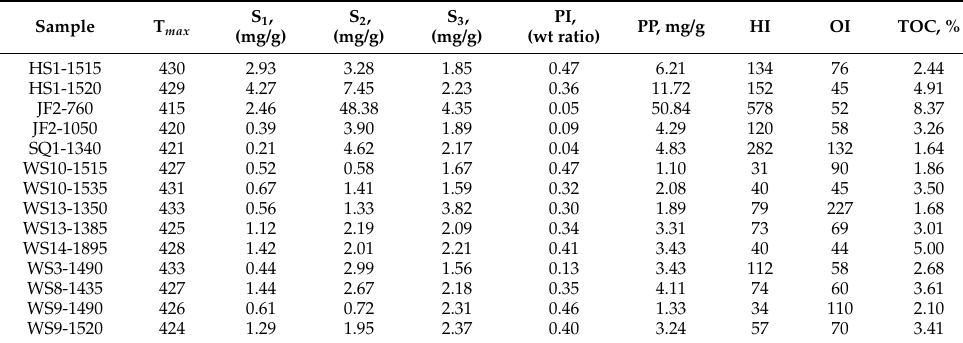
Table 5. Rock–Eval pyrolysis results.